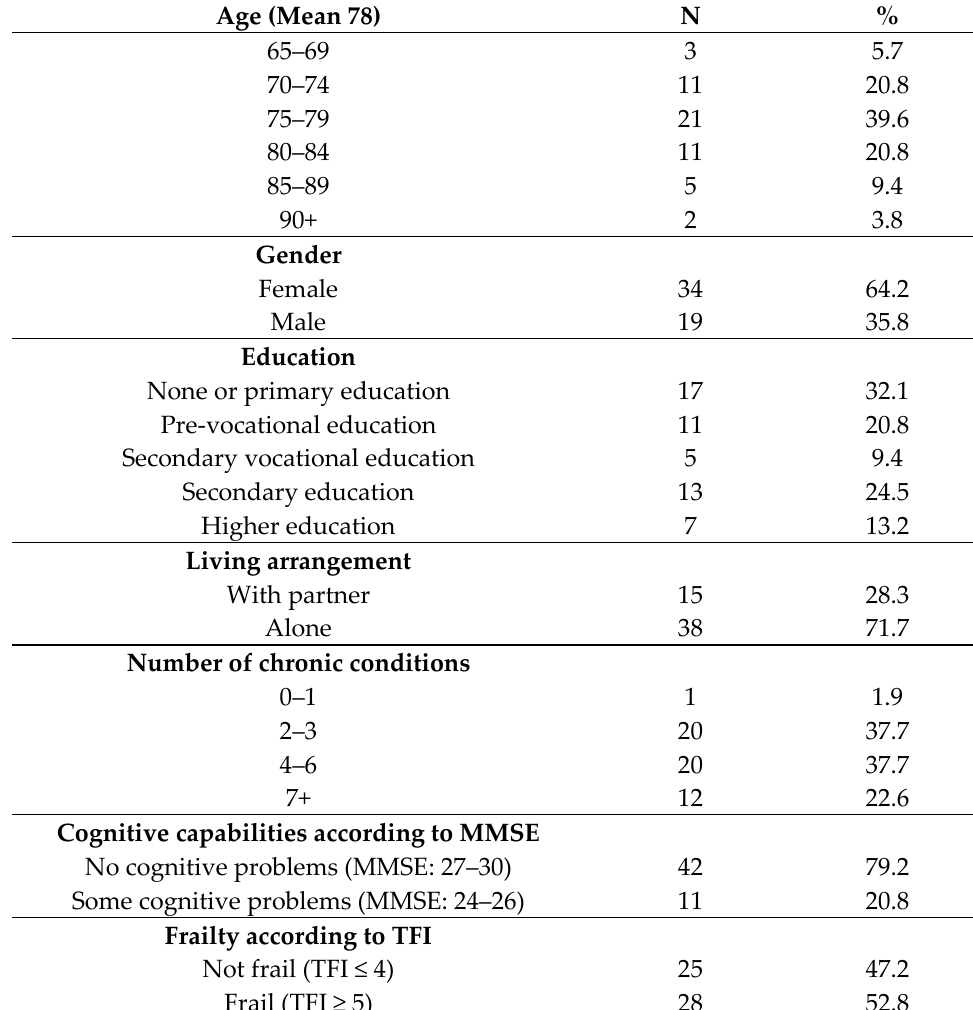
Table 1. General characteristics and health indicators (n =